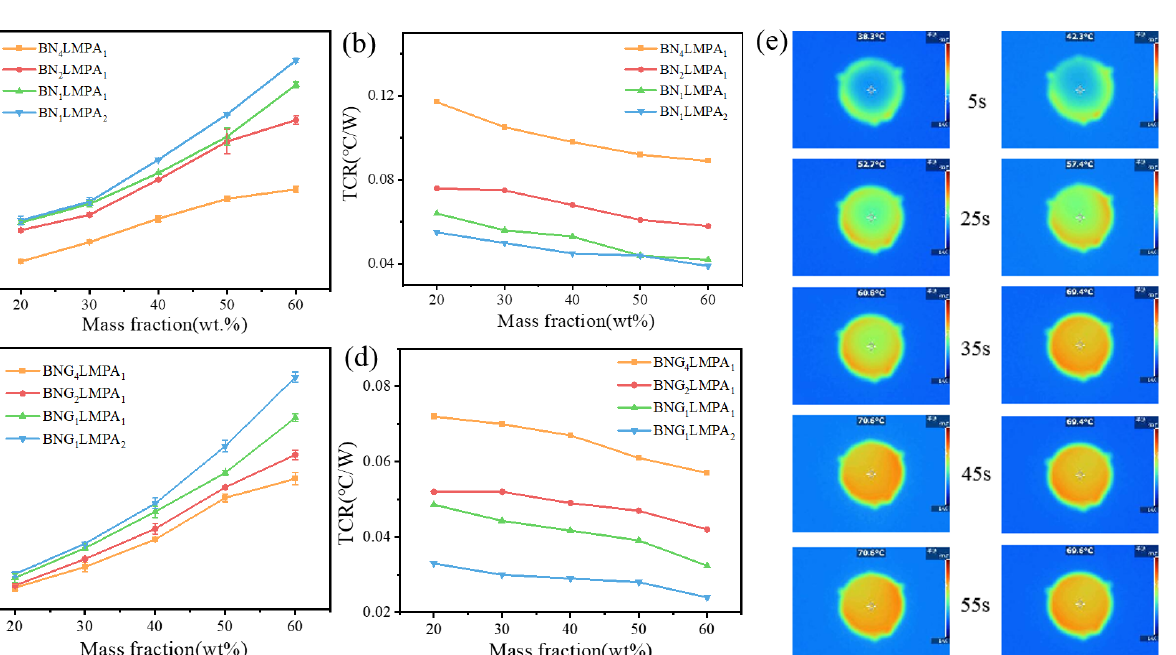
Table 1. Thermal conductivity of different TCG.·